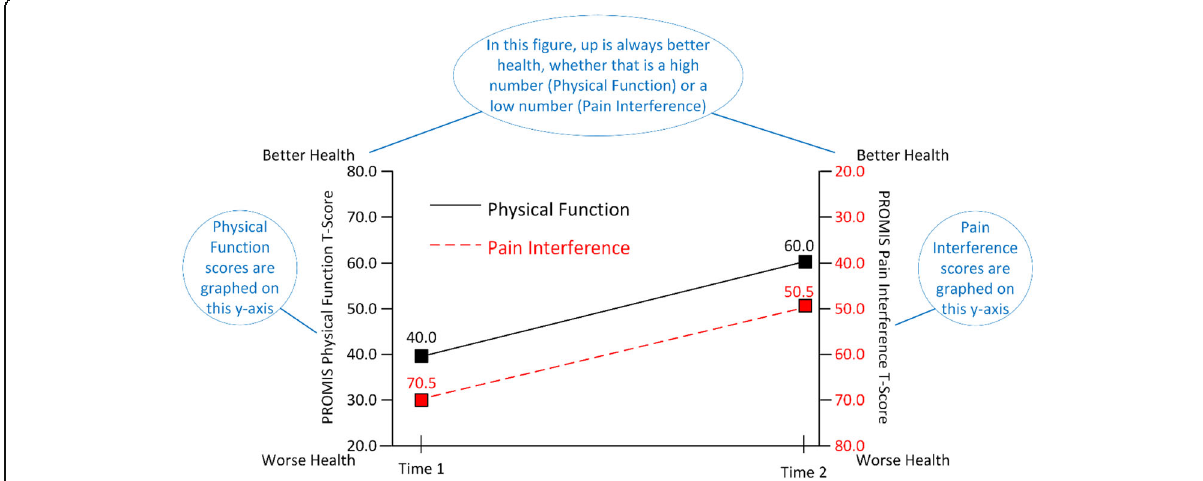
Fig. 2 Example results of change in function and symptom scores over time. Notes are in